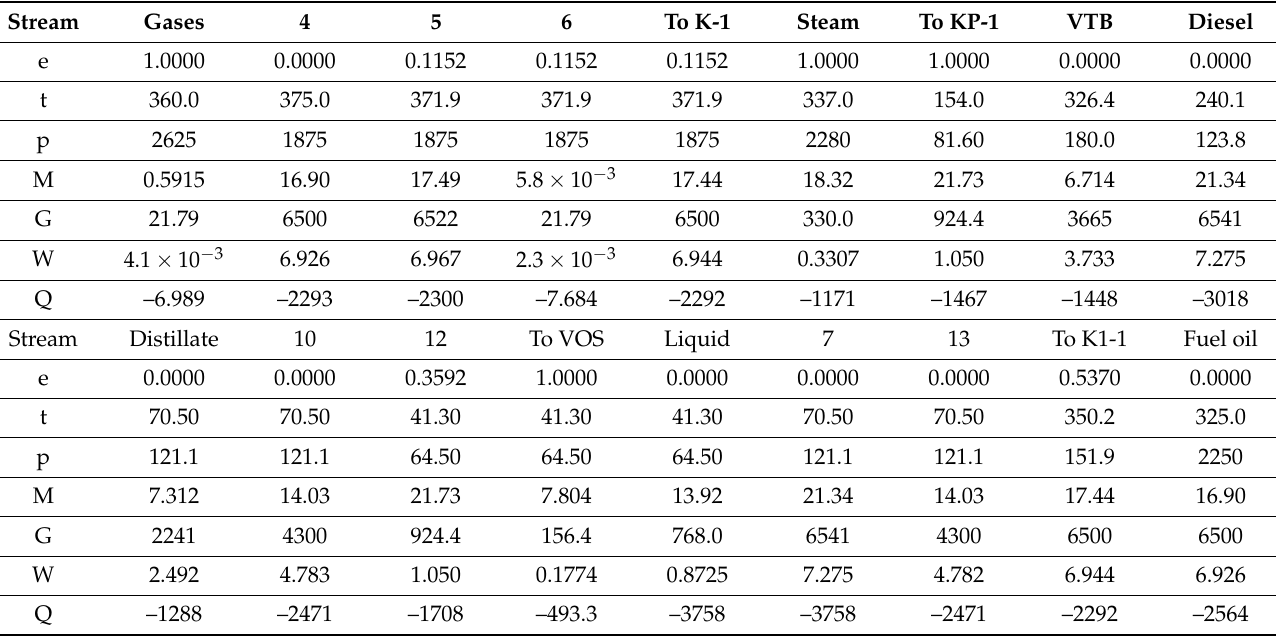
Table 13. Calculation results (mode 1).